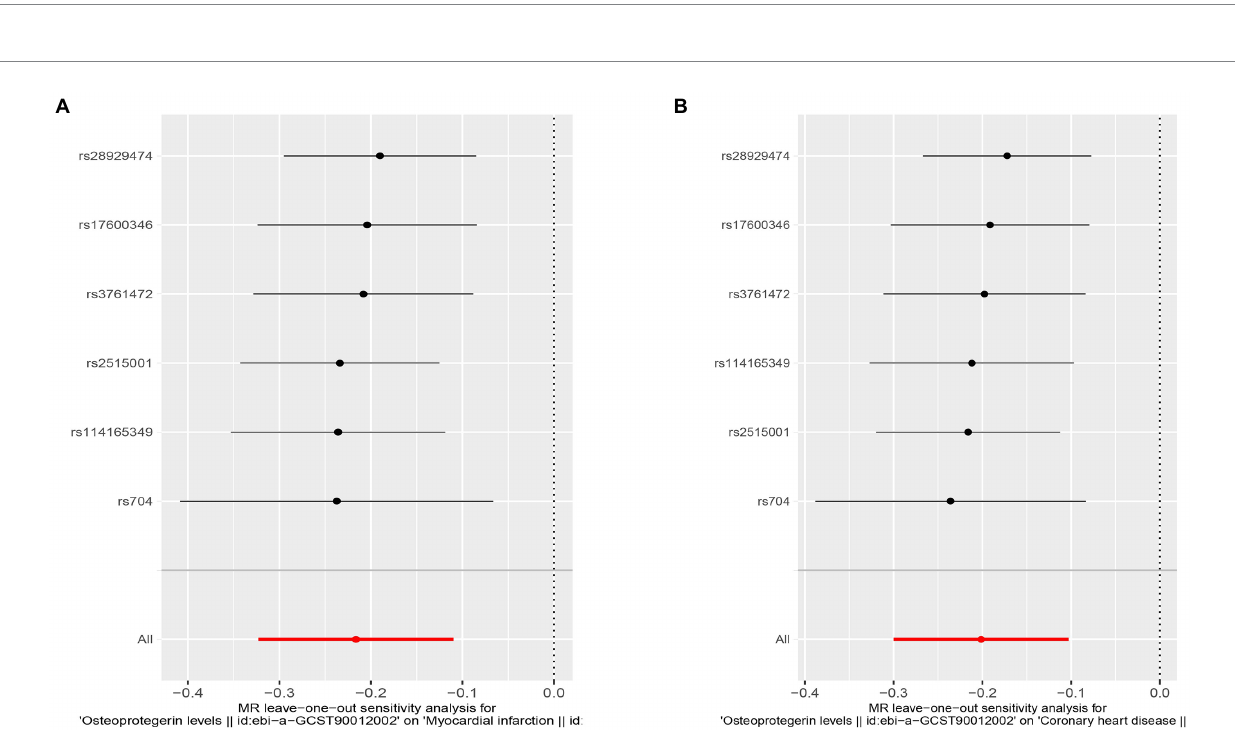
FIGURE 11 Sensitivity analyses using the leave-one-out approach for the association of plasma OPG level with outcomes after removing rs1385492. (A) AMI; (B)